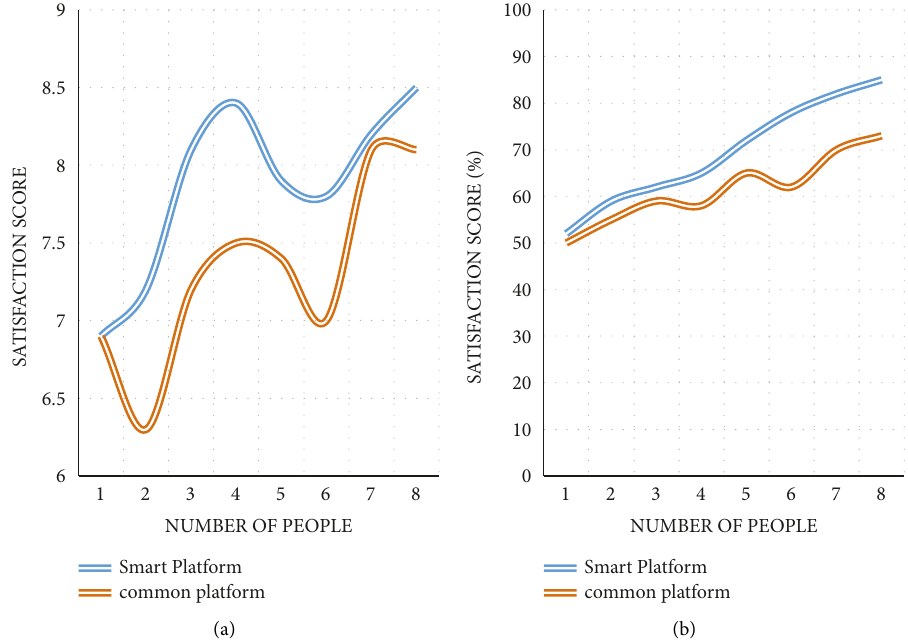
Figure 7: Comparison of satisfaction of TCM health platform between two groups. (a) Satisfaction scores of the two platforms. (b) Satisfaction comparison between the two platforms.